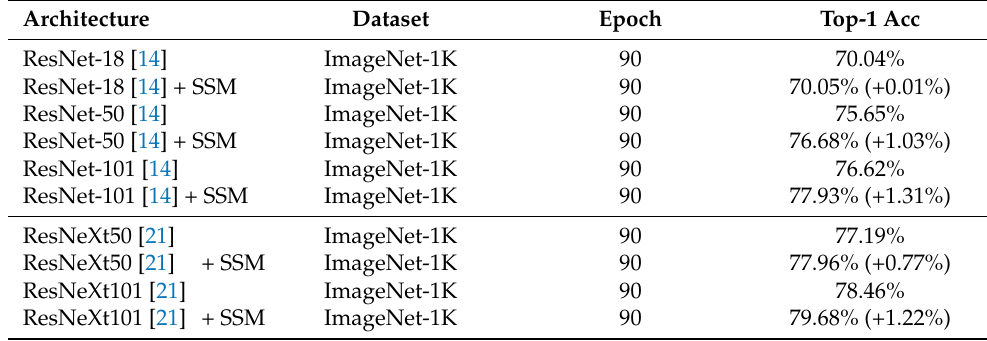
Table 1. Classification results on ImageNet-1K. Single-crop validation errors are